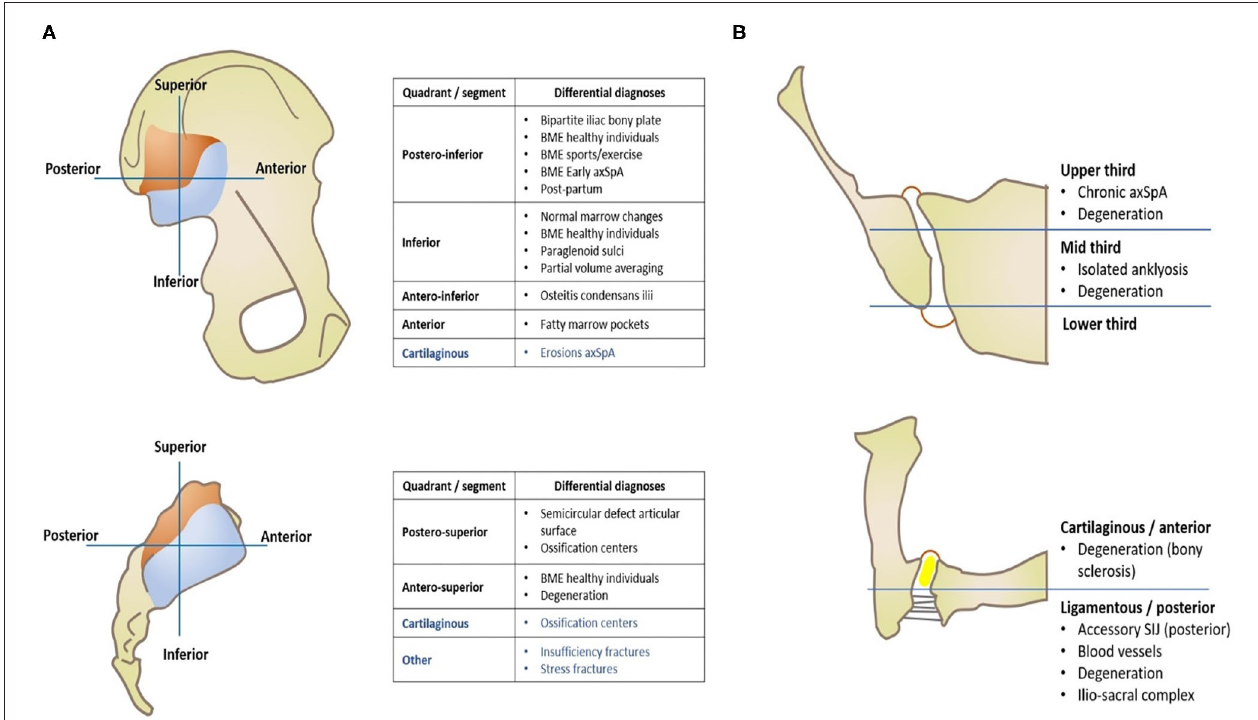
FIGURE 1 | Imaging of the sacroiliac joint—Topographic distribution of main anatomical variants and pathological conditions that mimic axSpA, separated by quadrants of each articular surface (A) and orthogonal planes (B) , namely coronal oblique (right upper image) and axial oblique (right lower